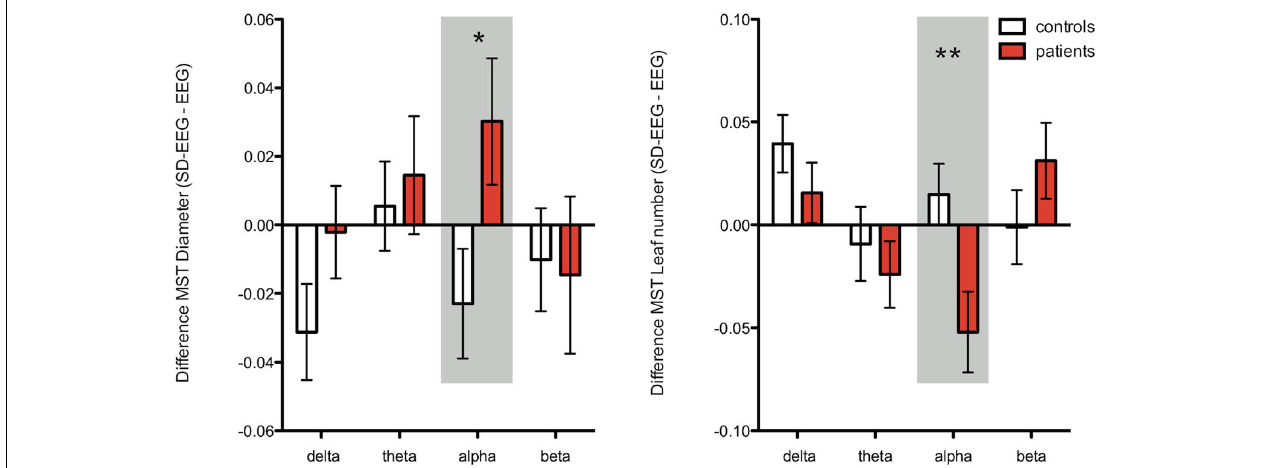
FIGURE 3 | Illustration of interaction effects from MST measures diameter (left graph) and leaf number (right graph) per frequency band as revealed with a repeated measures ANOVA (mean values and standard error of the mean bars). In this analysis we included only patients in whom the SD-EEG was of added value ( n = 15), and all controls ( n = 17) ( Table 4 ). There was a significant interaction for diameter in the alpha band; the diameter increased in patients whereas an opposite